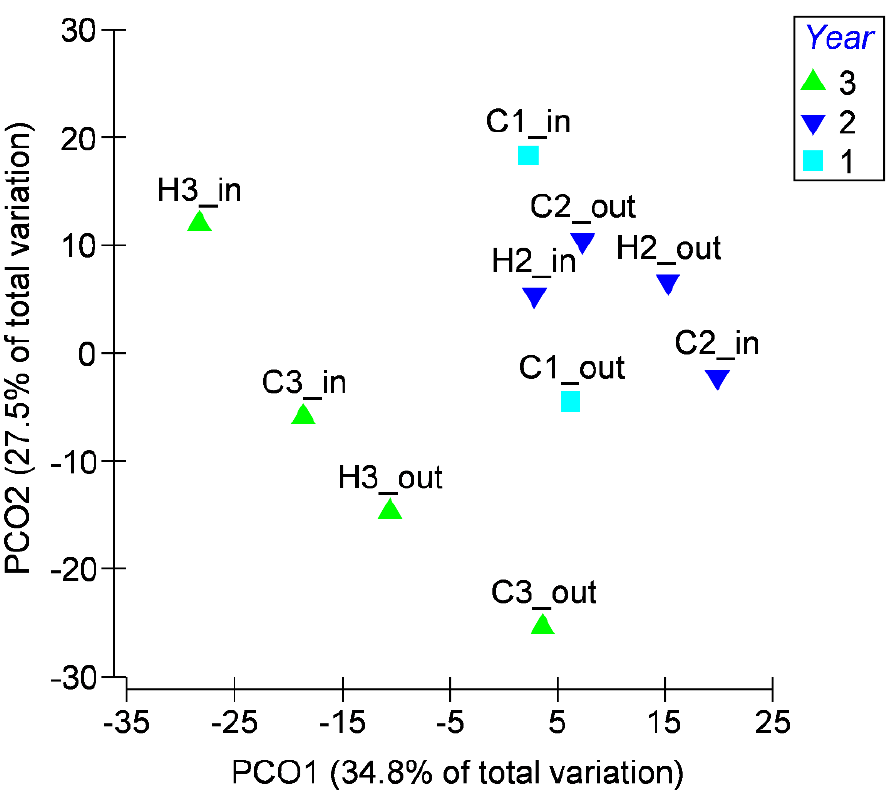
Figure 4. Principal coordinate analysis (PCO) of the substrate associated bacterial communities based on Bray–Curtis similarity matrix showing samples colored by year.